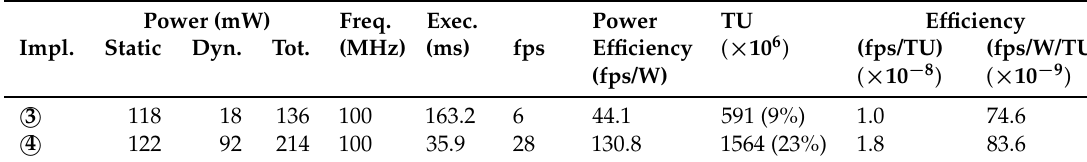
Table 9. Power, resource and combined efficiency comparisons of IPPro-based k -means clustering